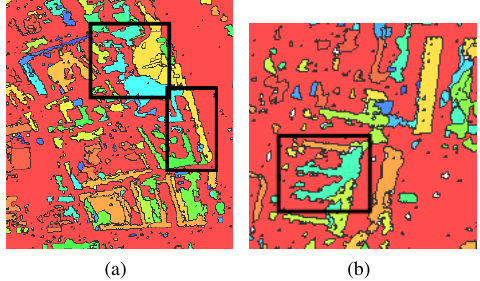
Figure 14: Results of region growing where no pre-segmentation is used. Black rectangles show examples of bad segmentation that can be compared to results of Figures 13 and 15.